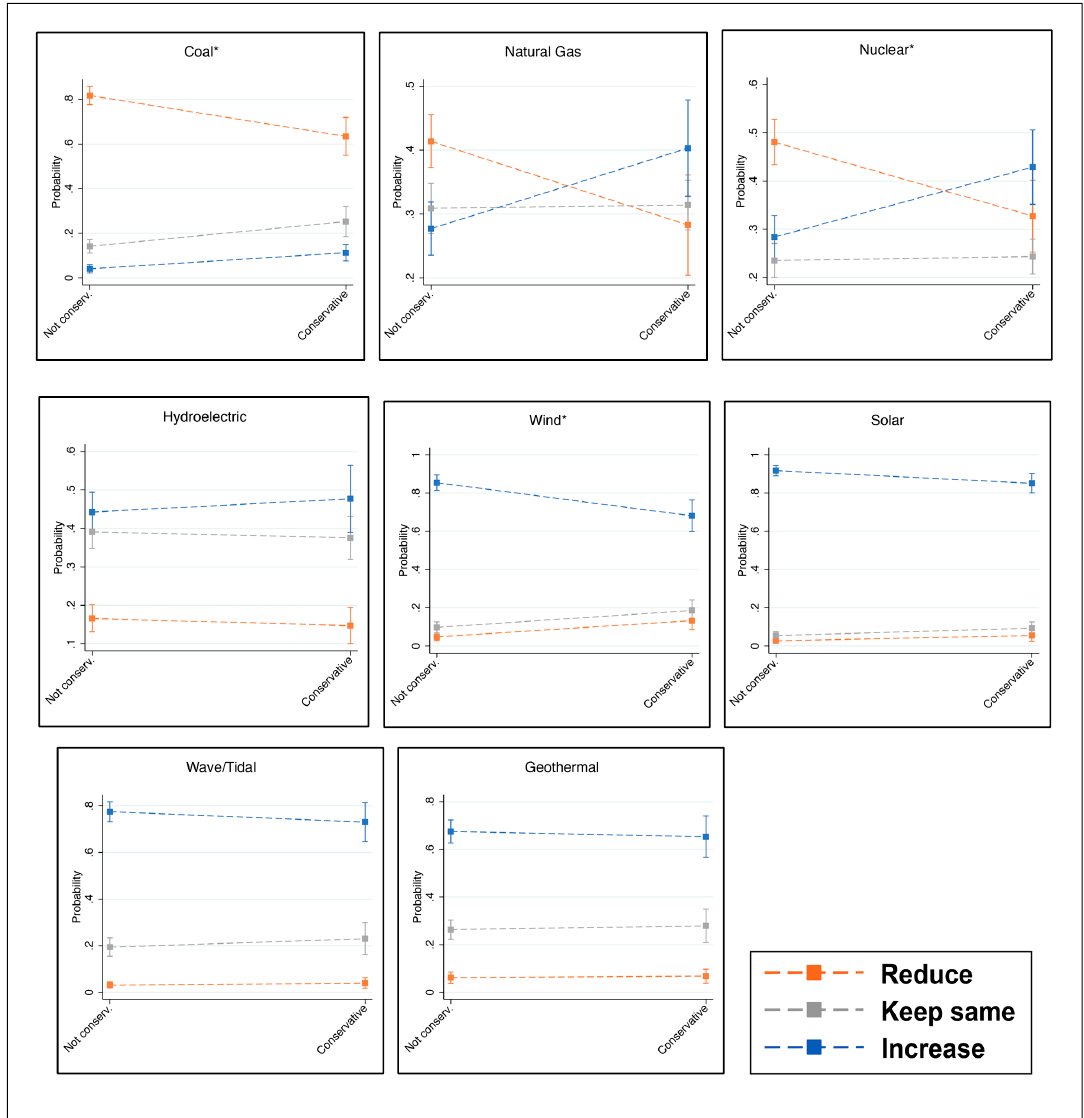
Figure 3. Predicted margins plots for support for eight energy sources by political ideology, with 95% confidence intervals. Predictive margins plots hold all other variables in regression models constant. (* denotes that ideology was a statistically significant predictor variable in the regression model).